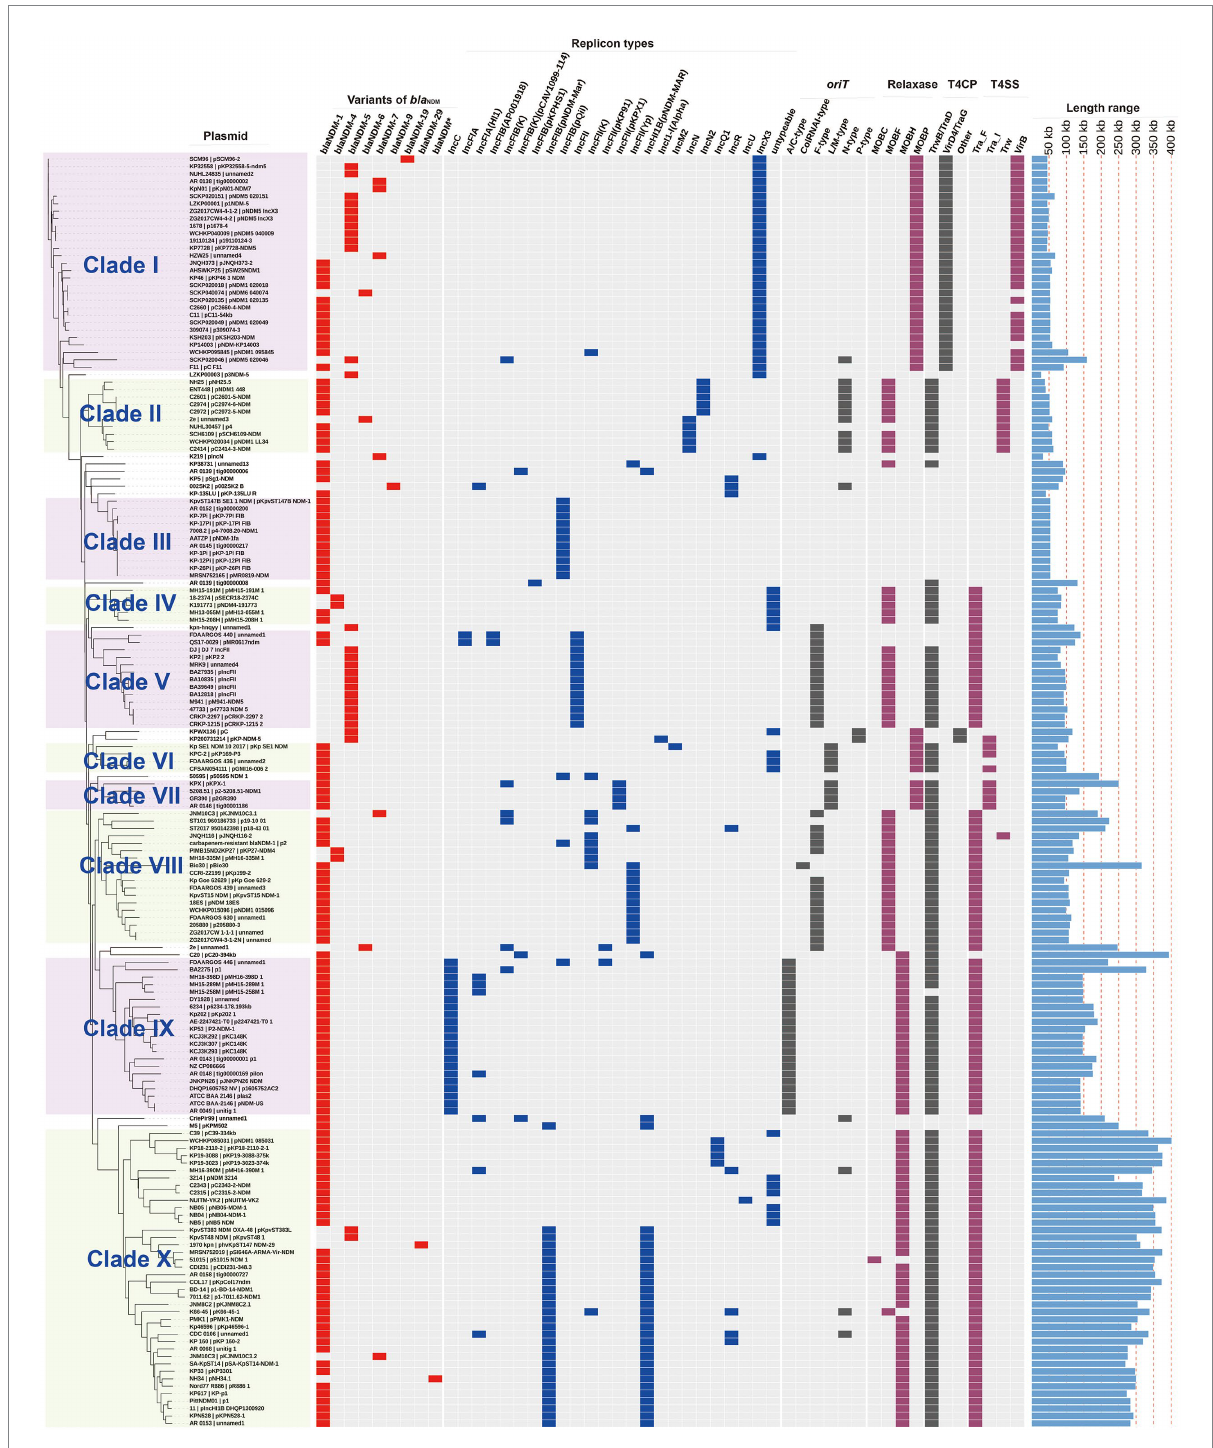
FIGURE 2 Details of variants of bla NDM genes, replicon types, conjugative transfer regions, geographical distributions, host STs, and length distribution of the 171 bla NDM -harboring plasmids of K. pneumoniae . The four categories of information present in this figure include the phylogenetic cladogram, variants of bla NDM , replicon types, conjugative transfer regions ( oriT , relaxase, T4CP, and T4SS), geographical distributions, ST types of host strains, and length distribution of the 171 bla NDM -harboring plasmids of K. pneumoniae . bla NDM* representing an unknown variant of bla NDM